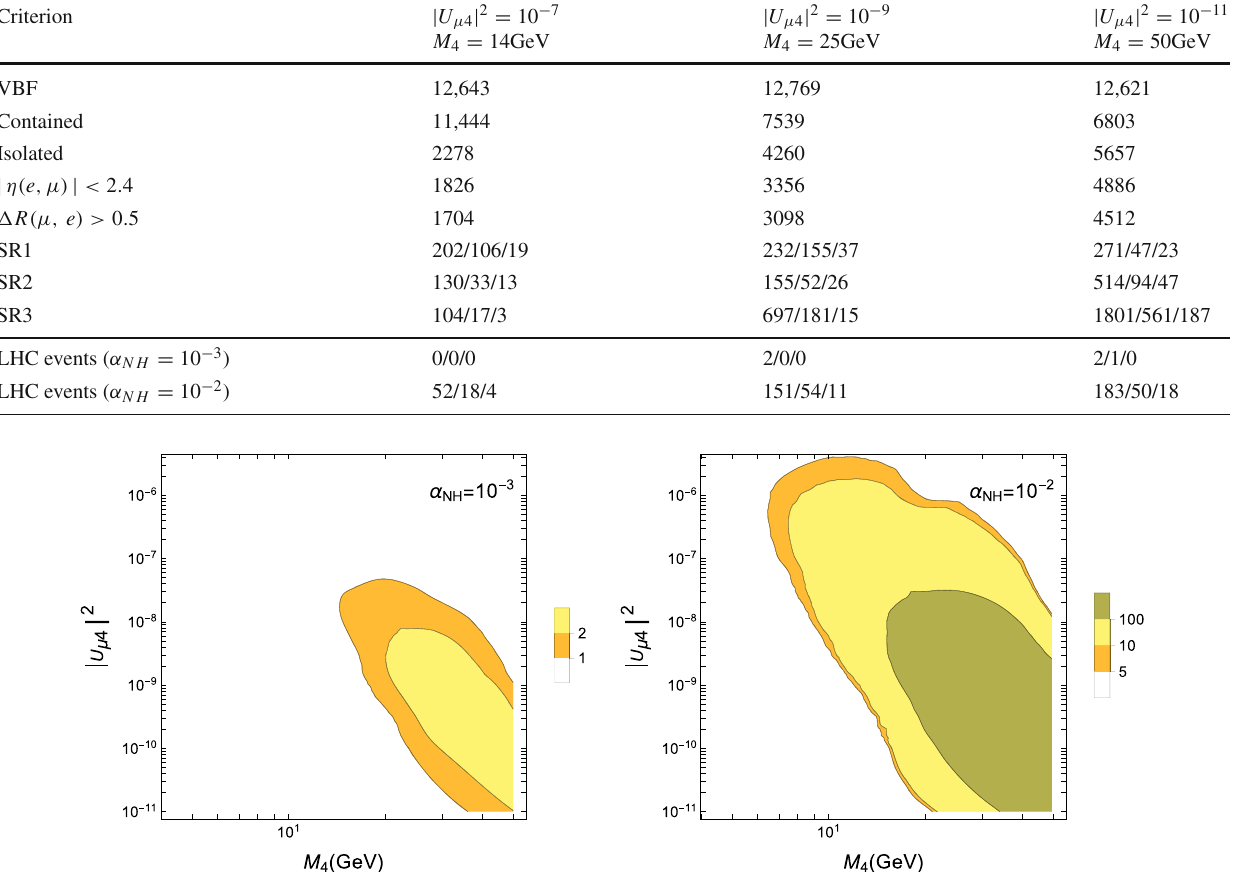
Table 5 As in Table 4, but for the extended model. On the last two rows we show the number of events expected at the LHC for two values of α NH Criterion